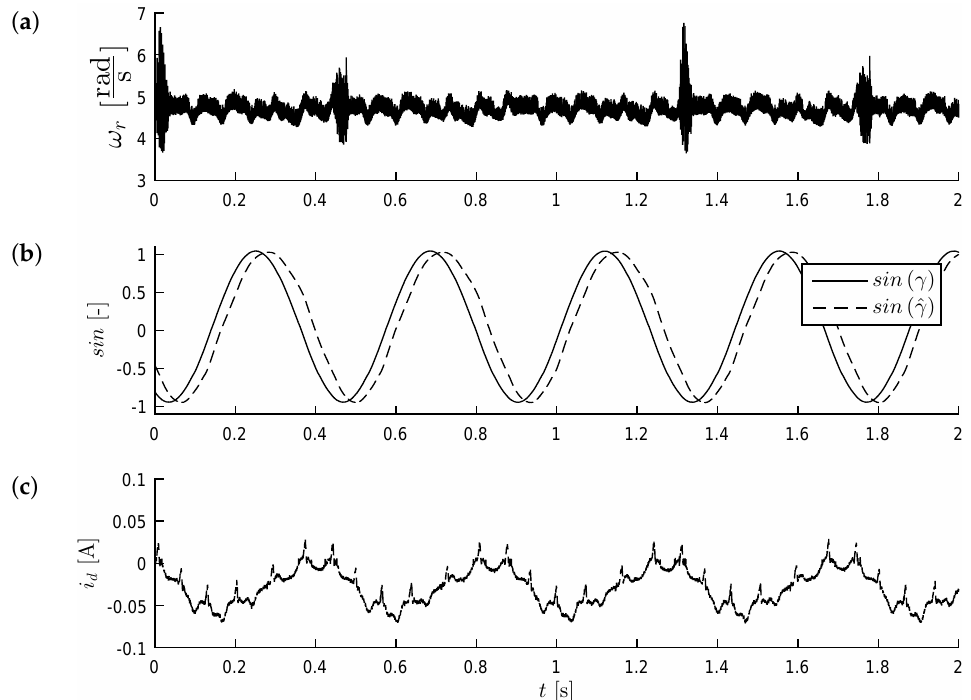
Figure 19. Low-speed control structure at steady state, ω ref = 4.8 rad position sine—sin ( γ ) ( b ) and d axis current i d ( c )